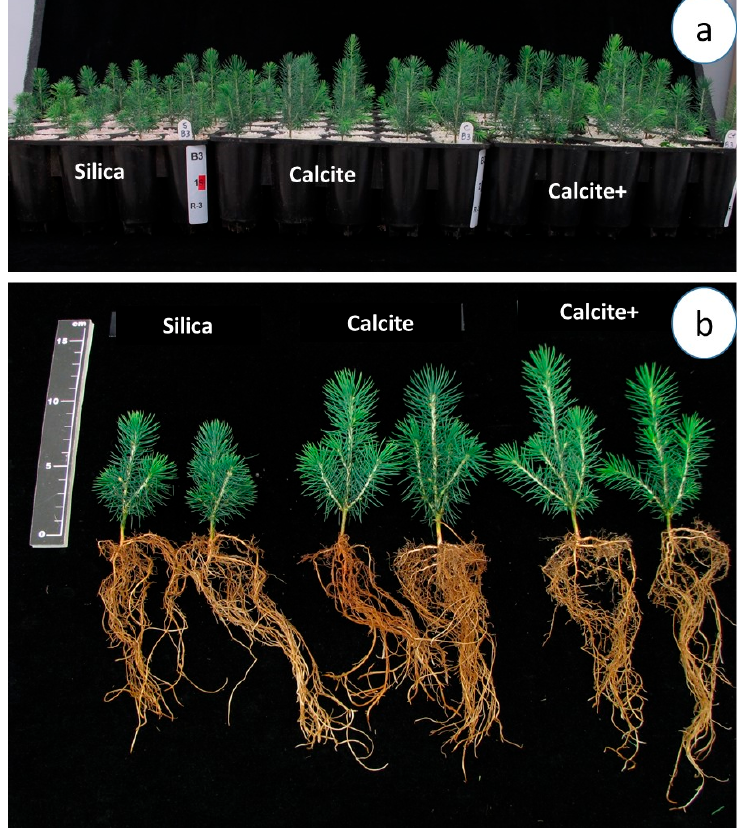
Figure 9. ( a ) Example of growth of white spruce seedlings (1 + 0) depending to the covering material (silica: 29 g/cavity, calcite: 24 g/cavity and calcite+: 31 g/cavity) (Photo: 8 September 2014); ( b ) Phenotypic aspects of roots and shoots of white spruce seedlings (1 + 0) depending on the covering material (Photo: 22 September